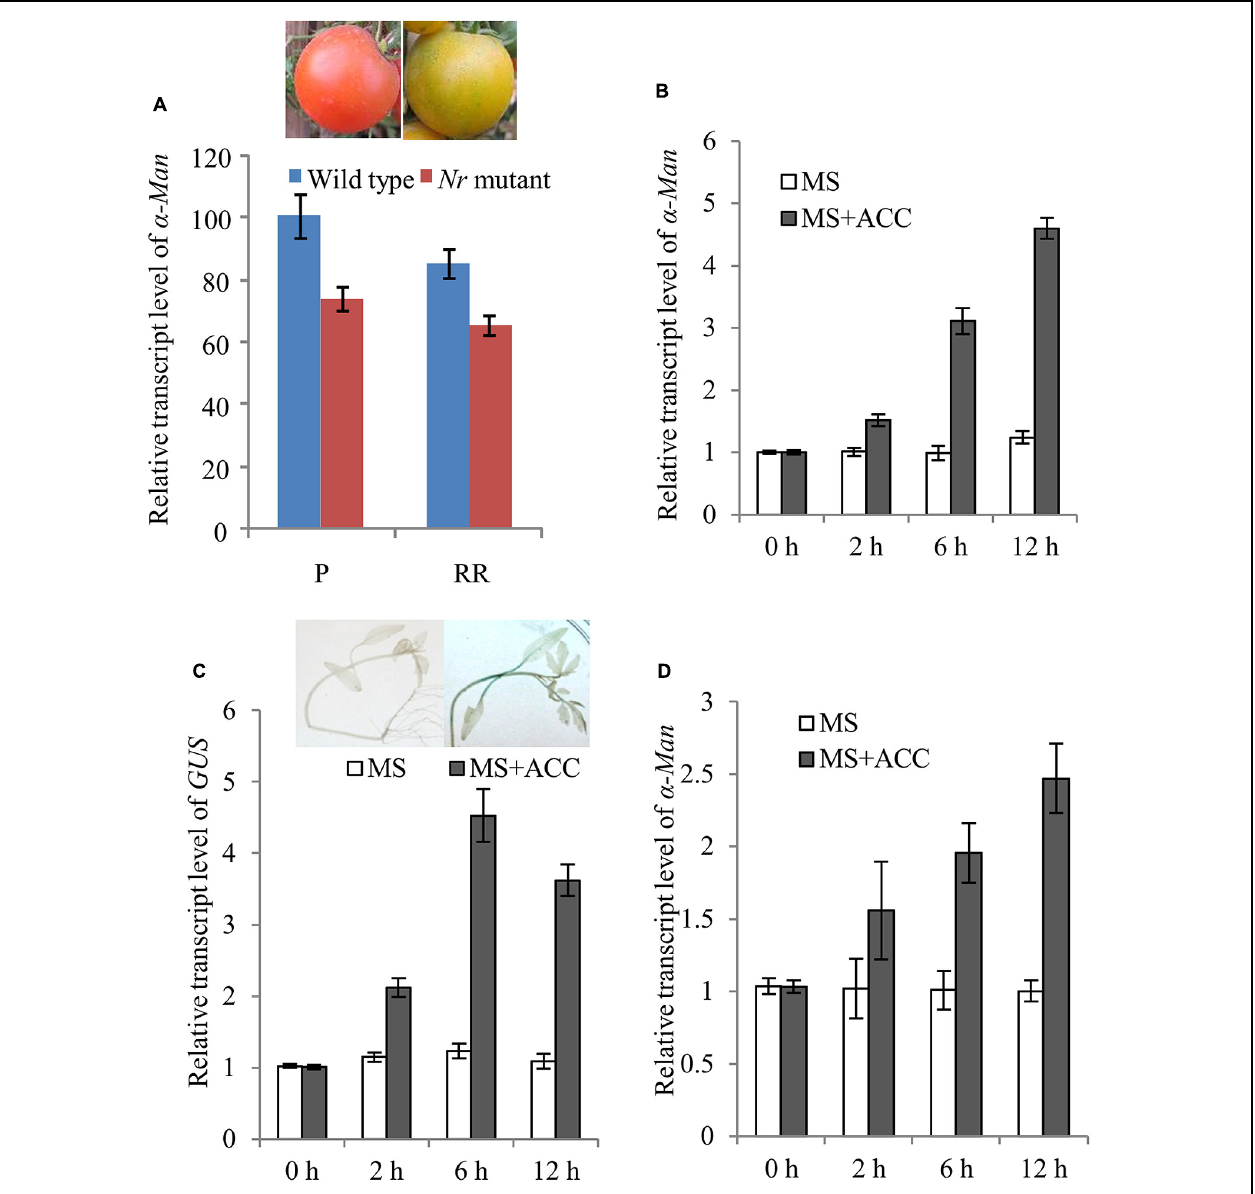
FIGURE 6 | Ethylene regulated expression of α -Man . (A) qRT PCR expression analysis of α -Man in fruits of wild type (Ailsa Craig) and ethylene receptor Nr mutant. (B) Ethylene inducibility of α -Man was confirmed with qRT-PCR analysis of α -Man transcript level in wild type seedlings and (C) GUS transcript level in MP::GUS transgenic seedlings. Histochemical assay was carried out after 4 h of treatment. Data are presented as the mean ( ± SE) of three biological replicates. (D) Ethylene inducible expression of α -Man in rin mutant seedlings was determined by qRT-PCR analysis after ACC